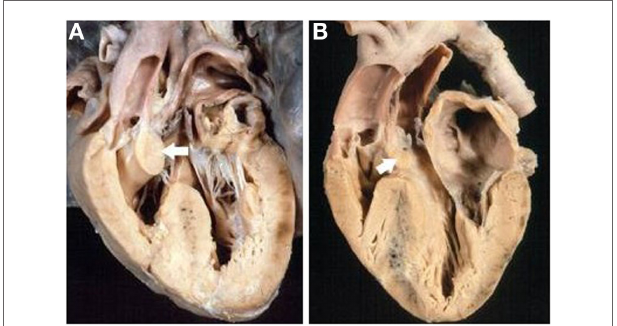
FigUre 5 | complete Tga with malaligment of the infundibular septum . (a) The deviation to the right of the infundibular septum is the cause of obstruction of the right ventricular outlet. The pulmonary valve overrides the ventricular septum. (B) In this specimen, the infundibular septum is deviated to the left causing obstruction of the left ventricular outlet. An overriding aortic valve is present.